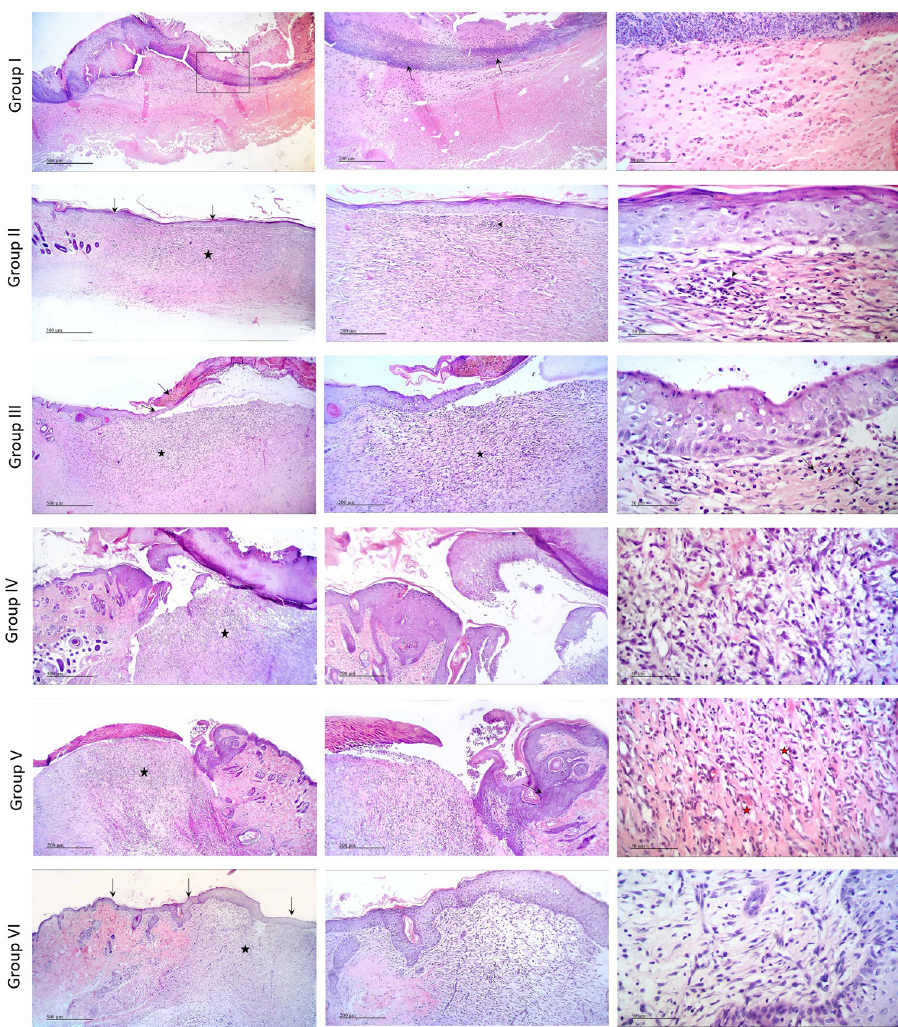
Fig 4. Histopathological view of wound healing and epidermal/dermal re-modeling in the groups administered different treatments on day 7 at magnification 4x, 10x and 40x.